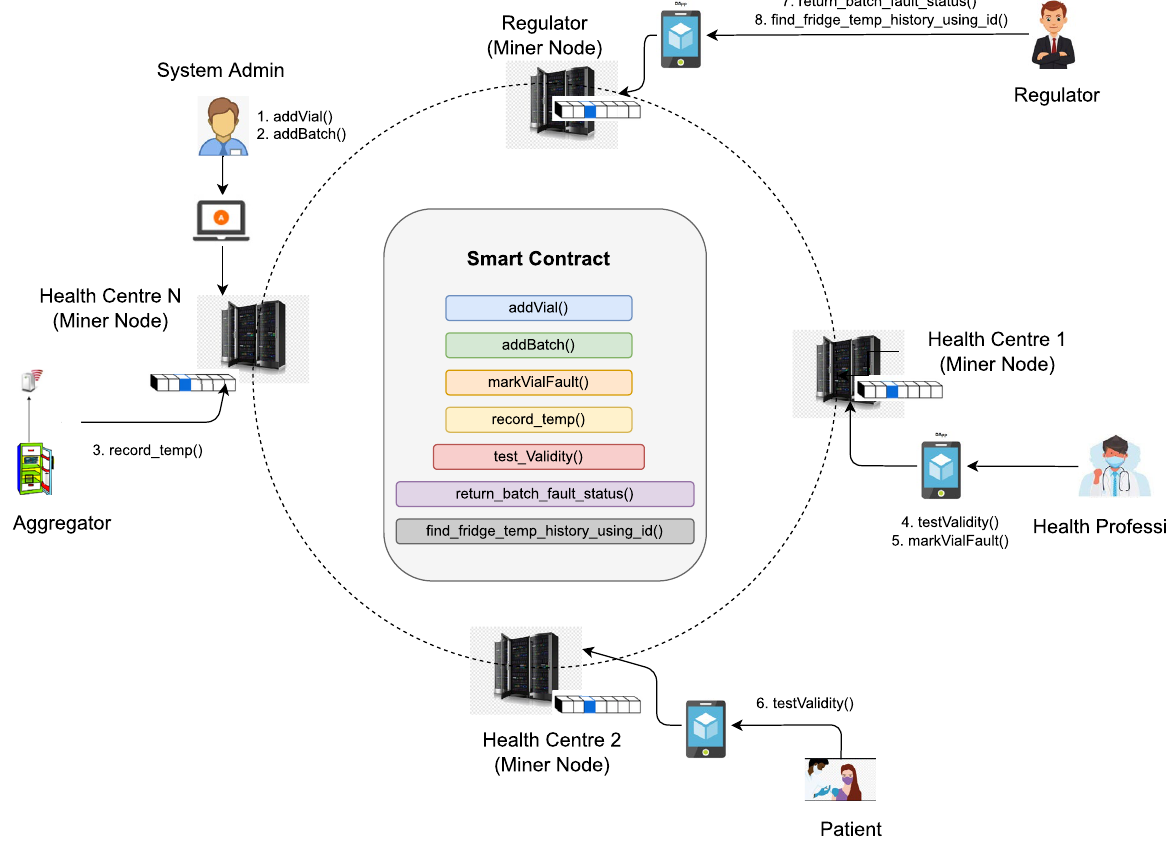
Figure 4. The architectural model of the proposed